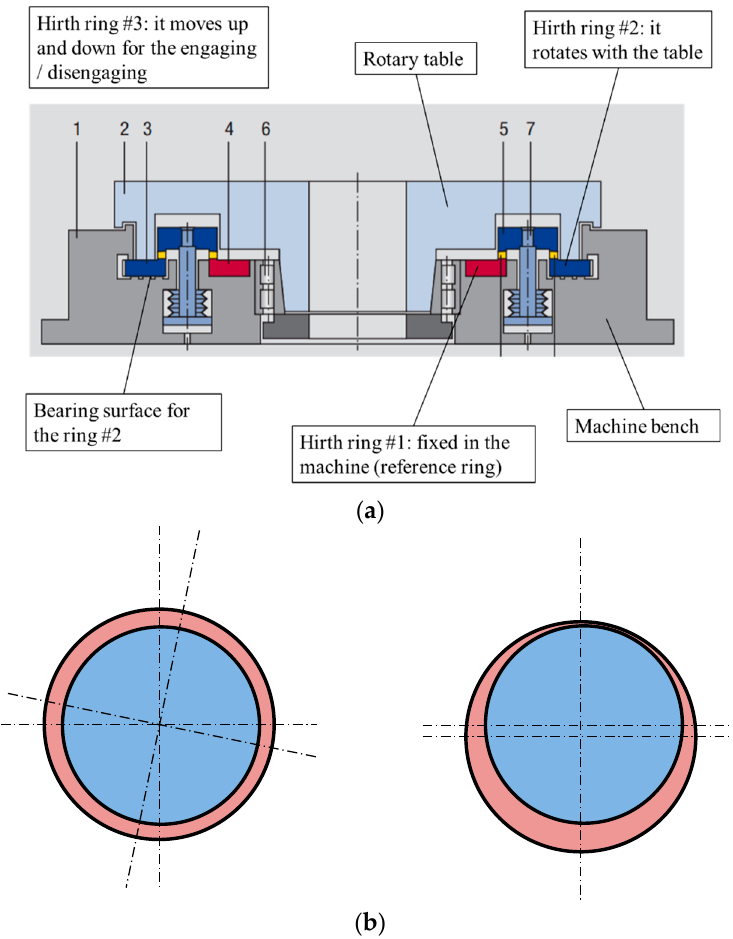
Figure 7. ( a ) Example of rotary table for the transfer machine tool; ( b ) position of ring #2 before engaging phase: left—the angle has to be adjusted; right—the center has to be adjusted.